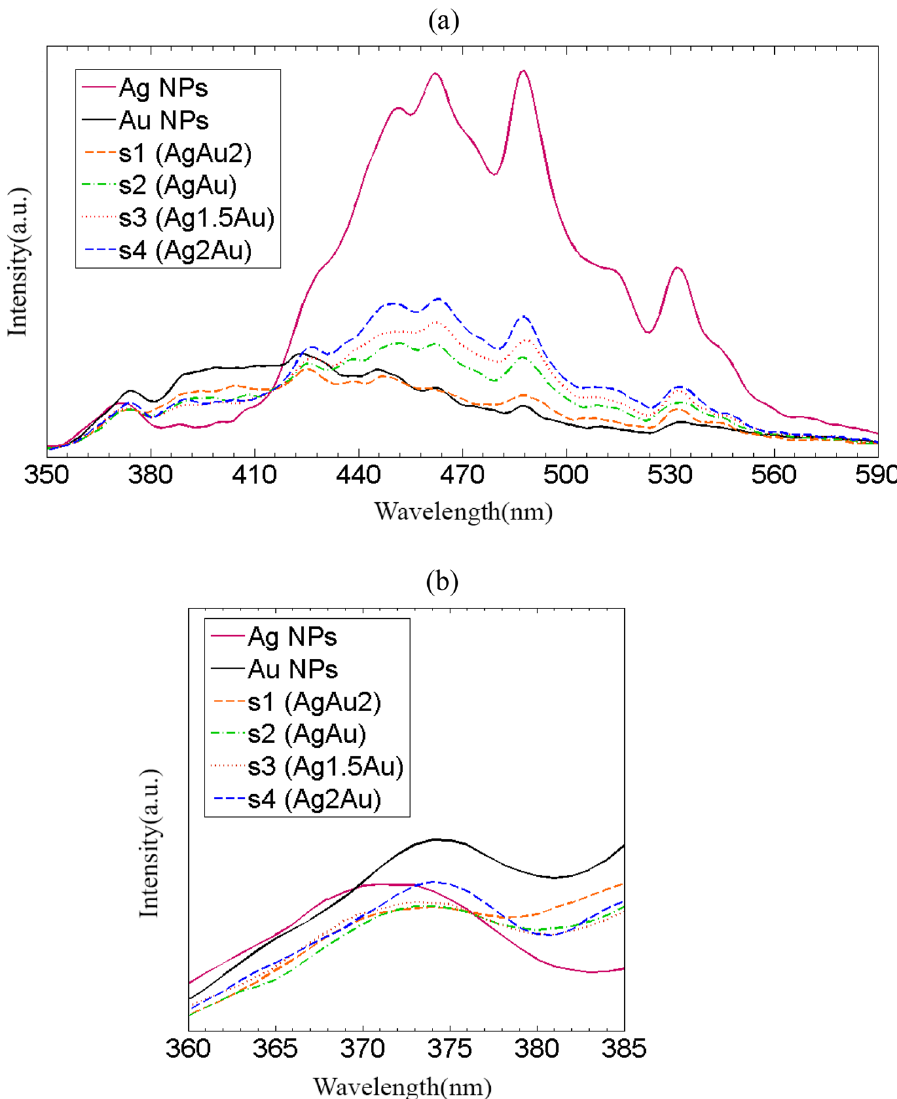
Fig. 14 Photoluminescence Spectrum of the Au, AgNPs and Au/Ag BNPs a Magnified wavelength range of 360 nm to 385 nm